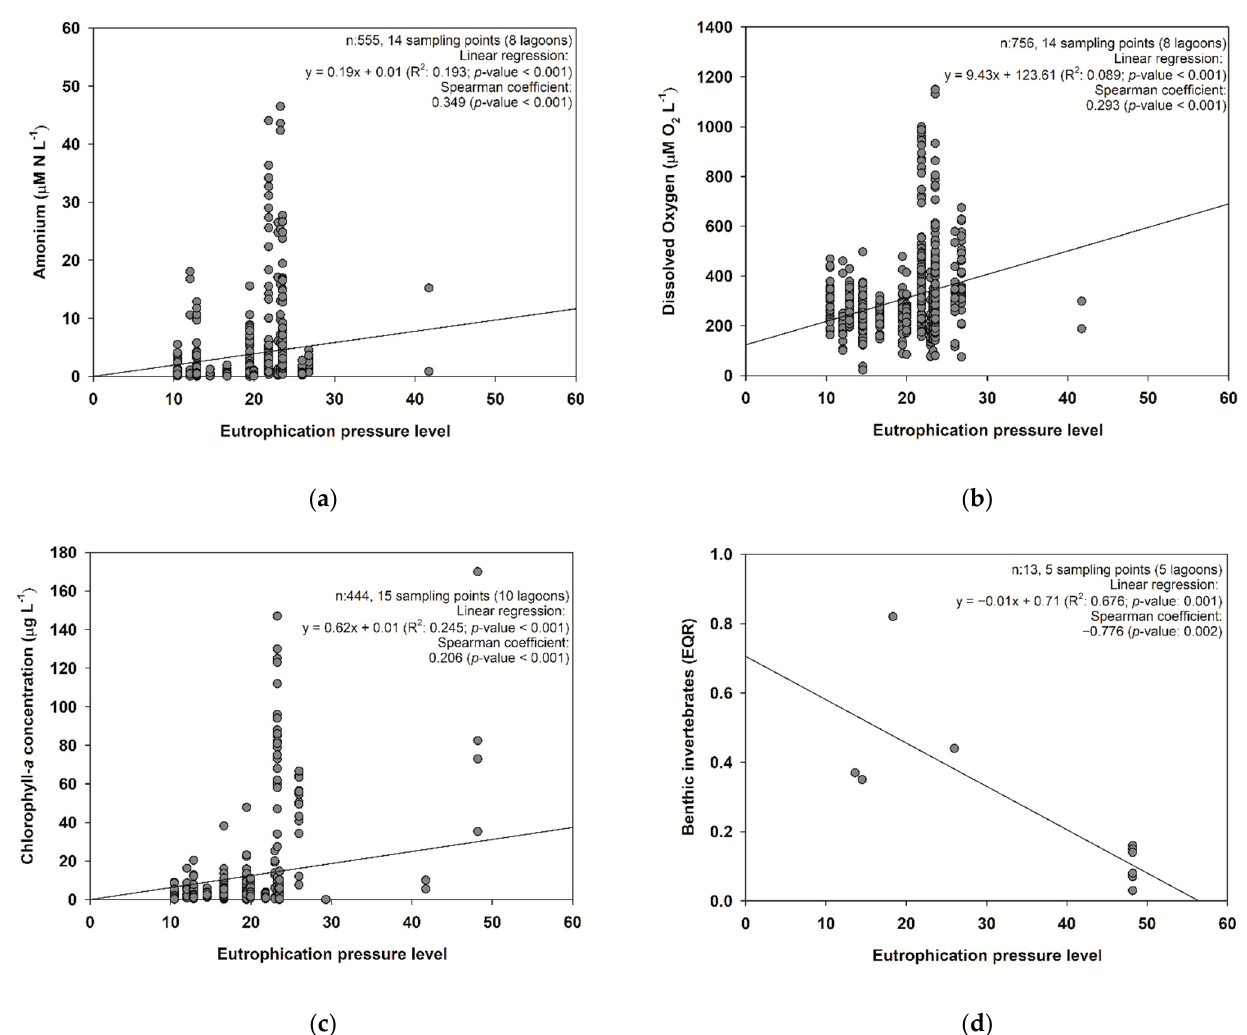
Figure 5. Relationship between the eutrophication pressure level and ( a ) ammonium concentration, ( b ) dissolved oxygen concentration, ( c ) chl- a concentration, and ( d ) benthic invertebrate index, as EQR. Spearman coefficient (with the significance of the correlation), as well as linear regression (with the R 2 and significance of the regression model) are shown.